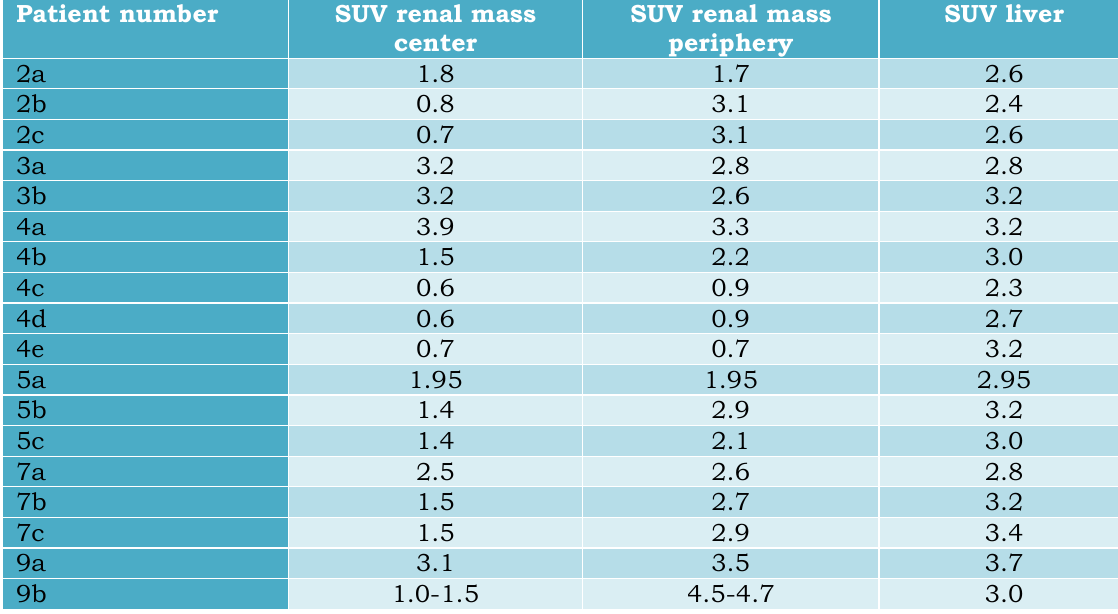
Table 2. In 6 patients, 18 F-FDG PET-CT imaging was performed before and after cryoablation (CA) Patient